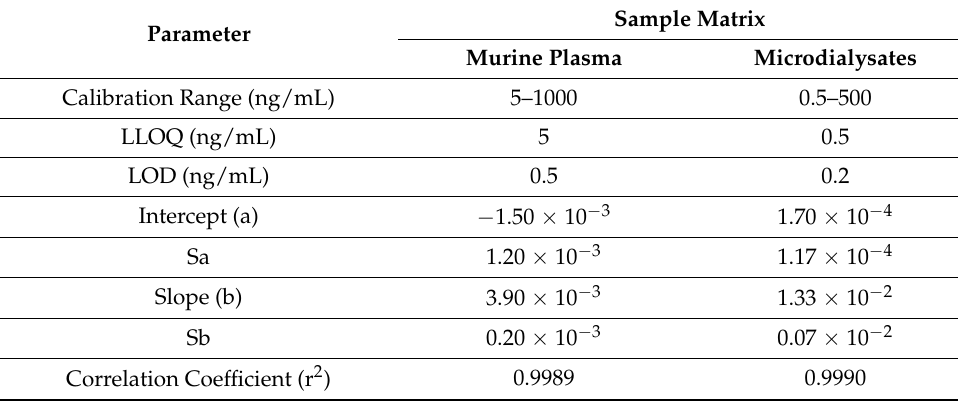
Table 1. Parameters for calibration curves in different matrices.